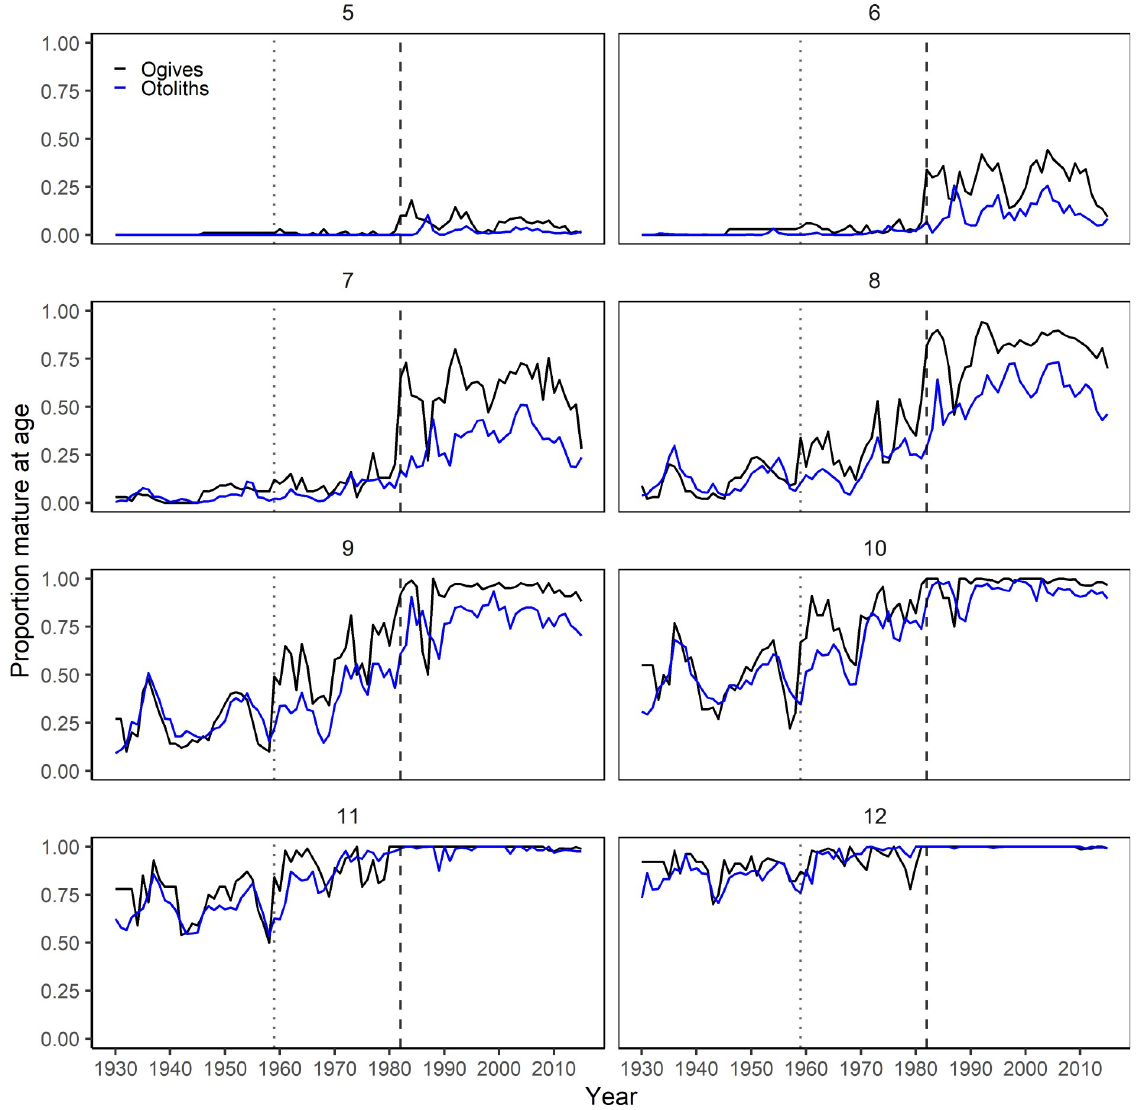
Fig 7. Proportions of mature-at-age per year and age class from the official stock assessment ogives (black) and reconstructed for each year from individual increments identified as spawning zones (blue). Vertical dotted line (1959) represents the beginning of the period combining Norwegian spawning zone data and Russian gonad readings for calculating maturity at age in stock assessment; vertical dashed line (1982) represents the beginning of yearly Barents Sea and Lofoten bottom trawl surveys and the change to using only gonad maturity stages in stock